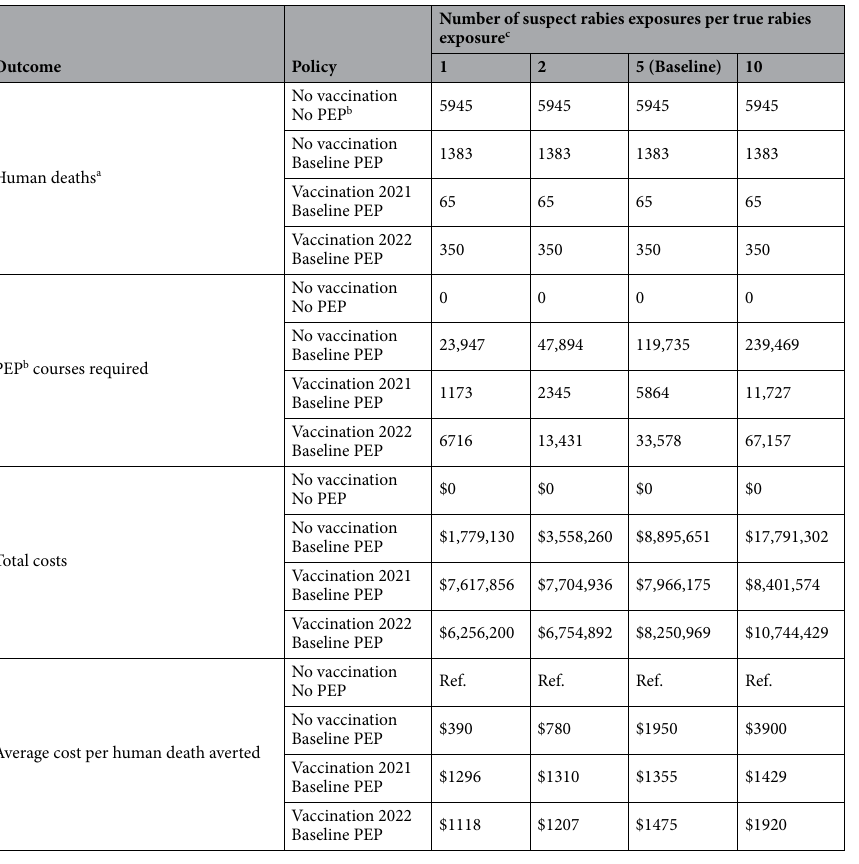
Table 2. Sensitivity analysis: 5-year health and cost effectiveness outcomes for different assumptions of PEP use efficiency. a Total human rabies deaths; we assume only 10% of these would be reported. b PEP = post- exposure prophylaxis. The baseline PEP assumption is that 80% (outside Ouest Department) or 85% (Ouest Department) of humans exposed to a suspected rabid dog receive PEP, and that 1/5 suspected exposures are true rabies exposures. In people with true rabies exposures, PEP reduces the probability of death. PEP coverage is assumed to remain fixed throughout 2021–2025 in all scenarios. c The number of suspect rabies exposures per true rabies exposure is a measure of PEP use efficiency. A value of 1 indicates that only individuals with exposure to animals that are truly rabid receive PEP. Increasing levels imply decreasing PEP use